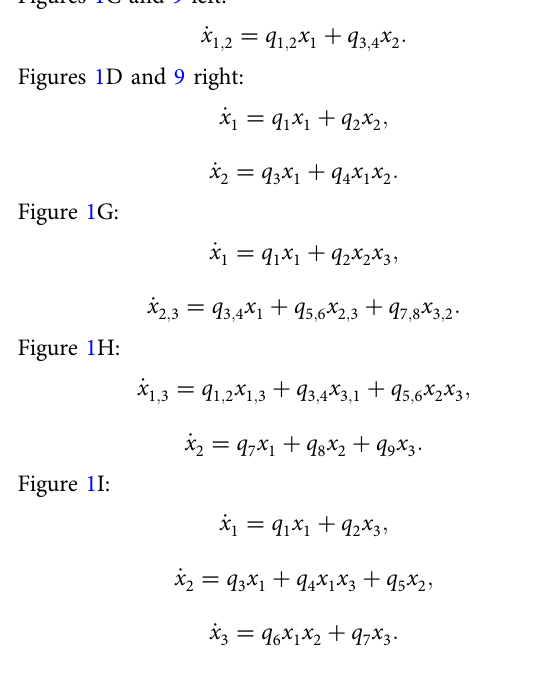
Cycles of creativity and diversi fi cation